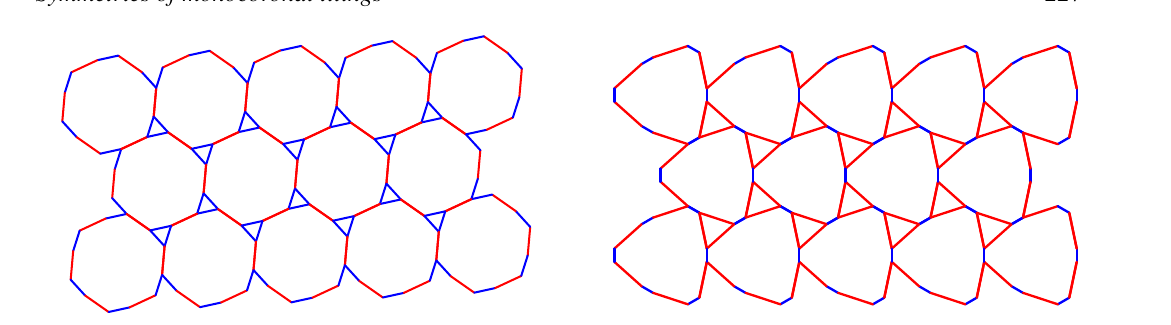
Fig. 38: Some consecutive angles of 12 -gons are equal.